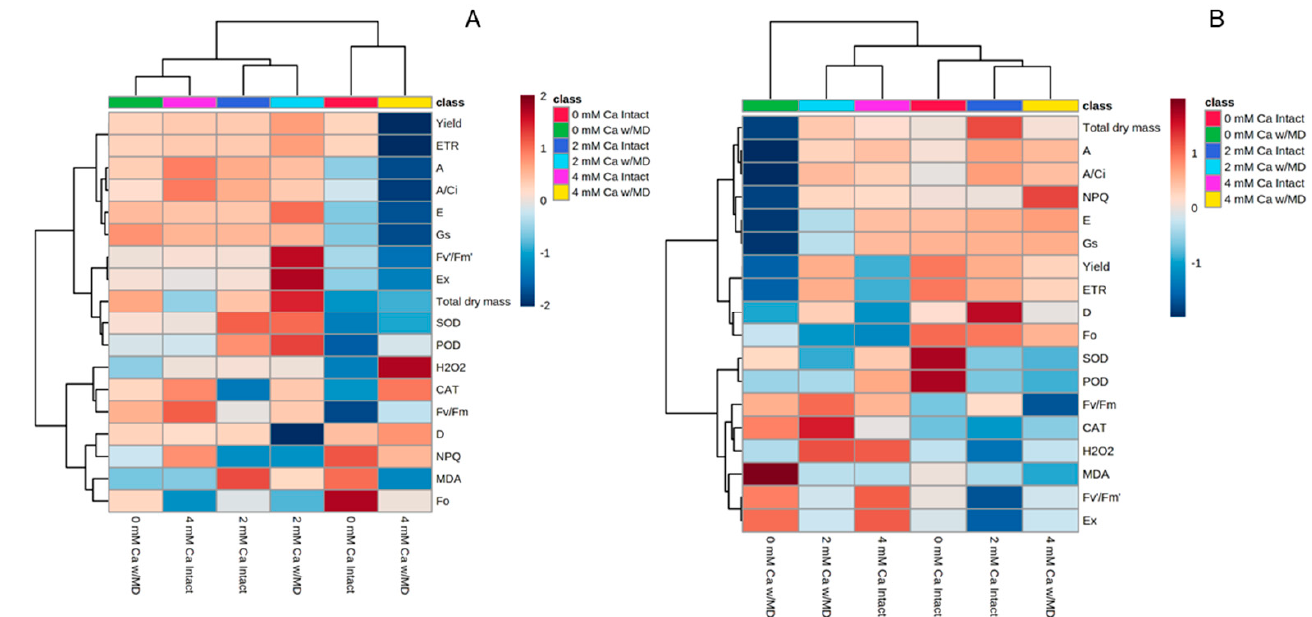
Figure 10. Heat map. Hierarchical cluster analysis presented as a heatmap on evaluations of maximum quantum yield for PSII photochemistry (Fv/Fm), energy dissipation as heat observed by non-photochemical quenching (NPQ), minimum Chl a fluorescence yield in the dark-adapted state (Fo), potential quantum efficiency of open PSII center (Fv’/Fm’), electron transport rate (ETR), effective quantum efficiency of PSII photochemistry (yield), light fraction absorbed by PSII antenna that is dissipated as heat (D), energy fraction not dissipated in the antenna that cannot be used for photochemistry stage (Ex), CO 2 assimilation rate (A), transpiration rate (E), stomatal conductance (Gs), RuBisCO’s carboxylation efficiency (A/Ci), total dry mass, foliar concentration of hydrogen peroxide (H 2 O 2 ), antioxidant enzyme activity of superoxide dismutase (SOD), catalase (CAT) and peroxidase (POD), and lipid peroxidation expressed by the formation of malonaldehyde (MDA) in Annona emarginata plants submitted to the treatments: 0 mM Ca 2+ without mechanical damage (intact), 0 mM Ca 2+ with mechanical damage (w/MD), 2 mM Ca 2+ intact, 2 mM Ca 2+ w/MD, 4 mM Ca 2+ intact, and 4 mM Ca 2+ w/MD, at evaluation times: ( A ). 0 (30 min) and ( B ). 90 days.